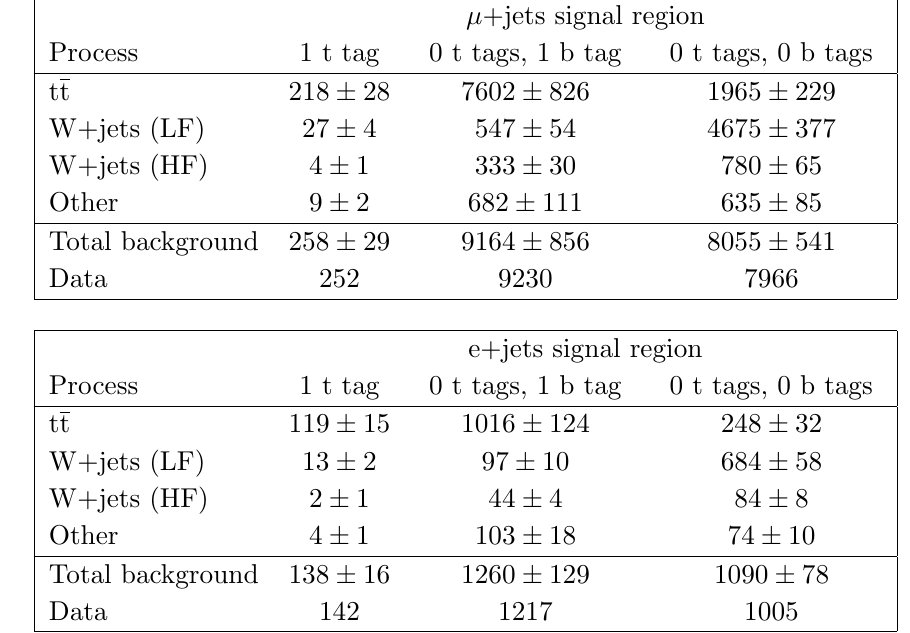
Table 3 . Numbers of events in the signal region for the lepton+jets analysis. The expected yields for SM backgrounds are obtained from the maximum likelihood (cid:12)t to the data described in section